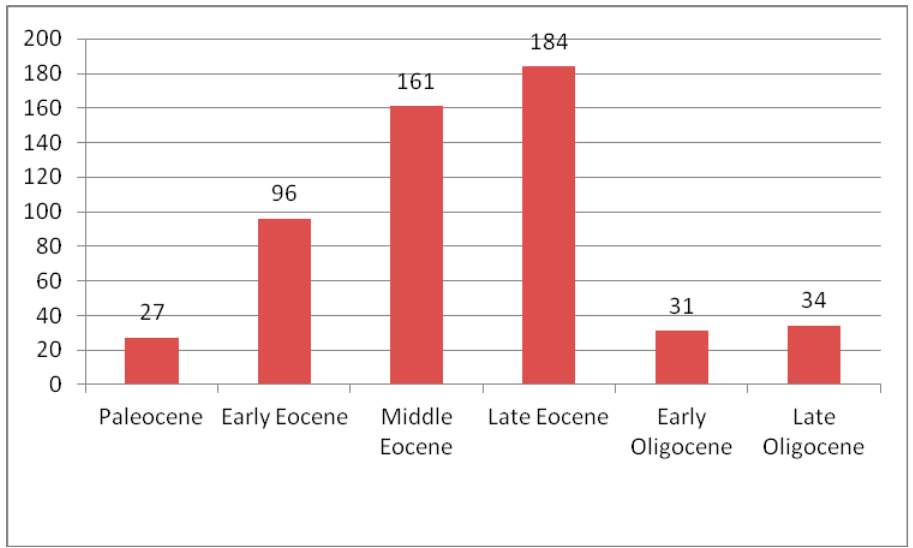
Figure 26. Change in number of Curculionoidea species in the Paleogene subepochs. The fauna of the Green River Formation is included in the Early Eocene.